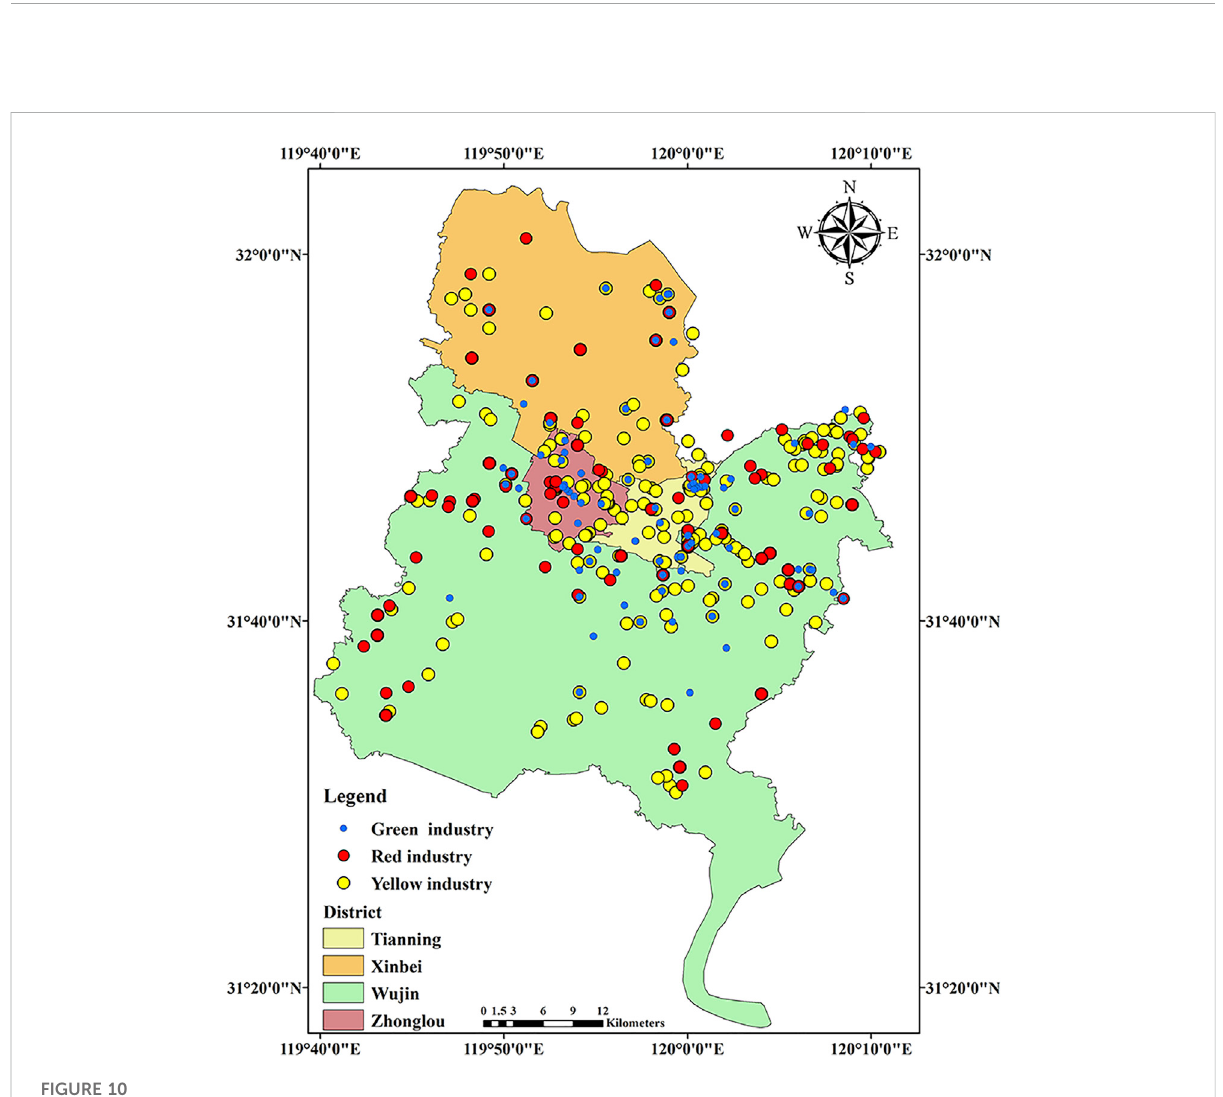
FIGURE 10 Spatial distribution of different industrial